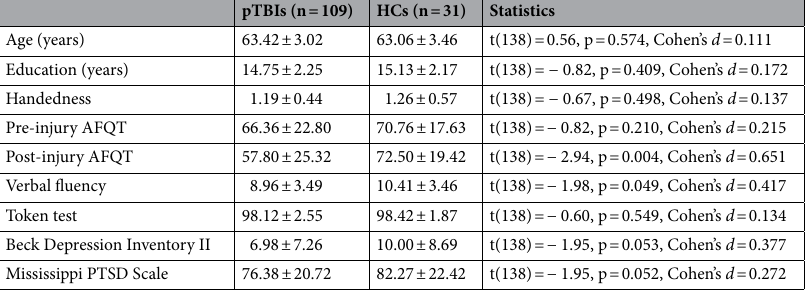
Table 1. Description of demographic characteristics and neuropsychological tests [mean ± SD], and t-test statistics for pTBI patients and HCs. The AFQT represents the Armed Forces Qualification Test—measure of intellectual ability; PTSD is used to represent Post-traumatic stress disorder. pTBIs and HCs are used to represent penetrating traumatic brain injury and healthy